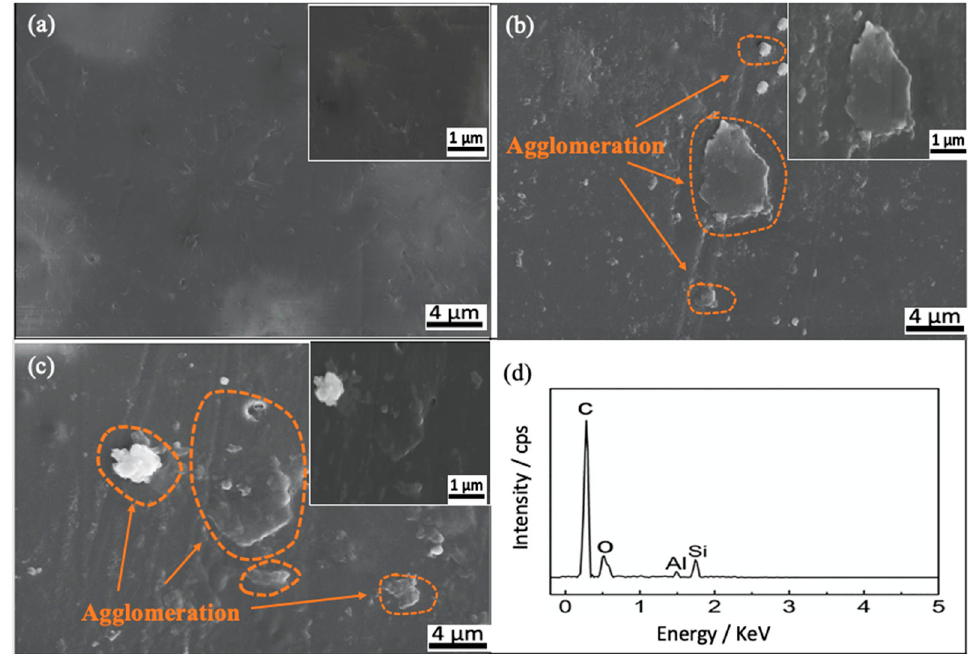
Figure 3. SEM images of the surface morphology of ( a ) C750 Gnp/epoxy, ( b ) M15 Gnp/epoxy, ( c ) X50 Gnp/epoxy coatings at low and high magnification as well as EDS spectra ( d ) measured at different points.